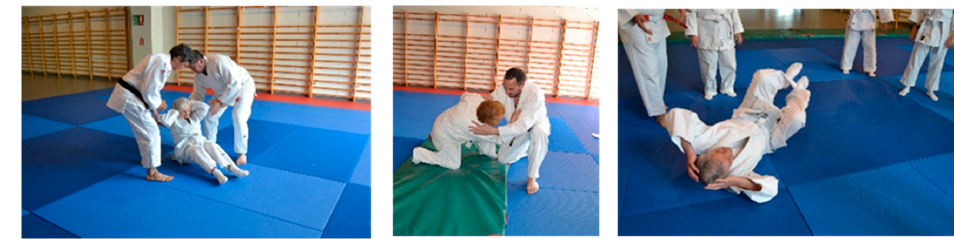
Figure 10. Adapted Judo falls.